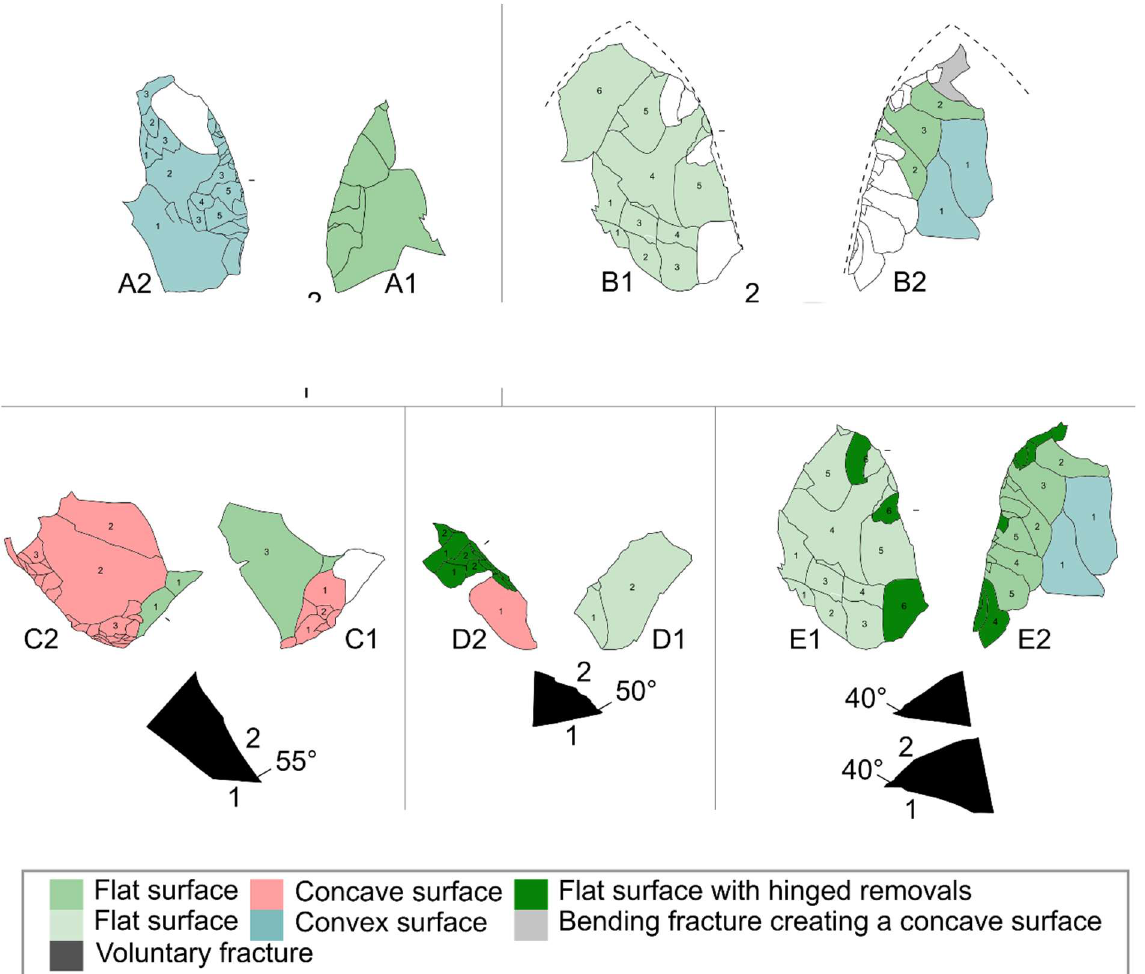
Figure 11. Technical and functional consequences of shaping operations on the bifacial piece from the C'3 base layer of the Barbas I site, Dordogne (Boëda 2001). The technical consequences are shown in frontal standard, while the functional consequences are shown in